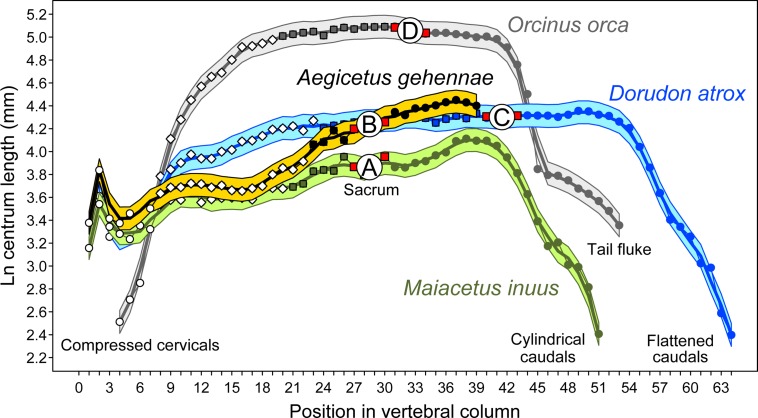
Vertebral length profiles for three stages of archaeocete evolution leading to modern whales.A, early middle Eocene protocetid Maiacetus inuus, a foot-powered swimmer (GSP-UM 3551; green). B, late Eocene protocetid Aegicetus gehennae, a transitional undulatory swimmer with an elongated body (CGM 60584; gold). C, late Eocene basilosaurid Dorudon atrox, an undulatory swimmer with an elongated body (UM 101215, etc.; blue). D, modern Orcinus orca, an oscillatory tail-powered swimmer (AMNH 34276; gray). Transition from A to B involved elongation of posterior lumbar through anterior caudal vertebrae (Fig 21), reduction of the sacroiliac articulation between the vertebral column and innominate, and loss of fusion between sacral vertebrae. Transition from B to C involved addition of mid-body vertebrae and lumbarization of sacral vertebrae. Transition from C to D involved shortening by reduction in the number of mid-body vertebrae, or, in some cetaceans, shortening of the lengths of individual vertebrae. Symbols are explained in Fig 21.